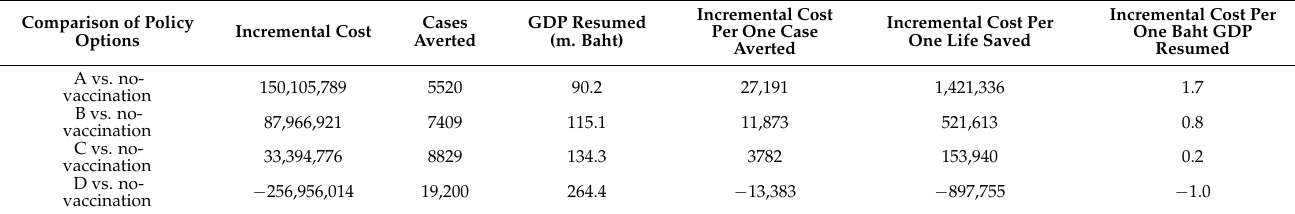
Table 6. Cost-effectiveness analysis by different policy